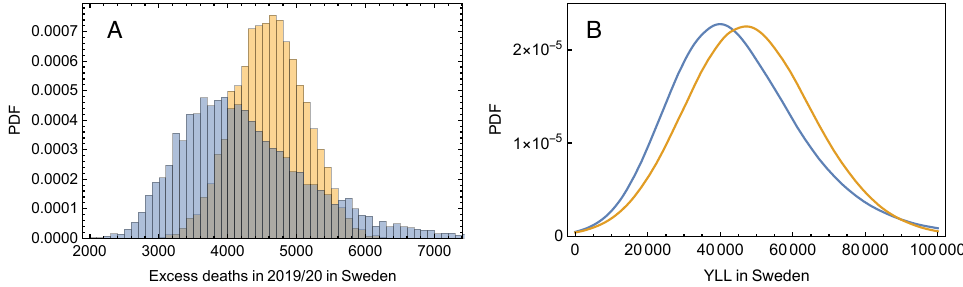
Figure 4. Effect of mortality displacement. ( A ) The yellow histogram shows the estimated proba- bility density function for excess deaths obtained from the Monte–Carlo simulation of the baseline. The blue histogram is the excess mortality adjusted for displacement according to Equation (4). ( B ) The blue curve is the estimated probability density function for years of life lost (YLL) obtained from Equation (1), and the blue curve is the probability density function for YLL after adjusting for mortality